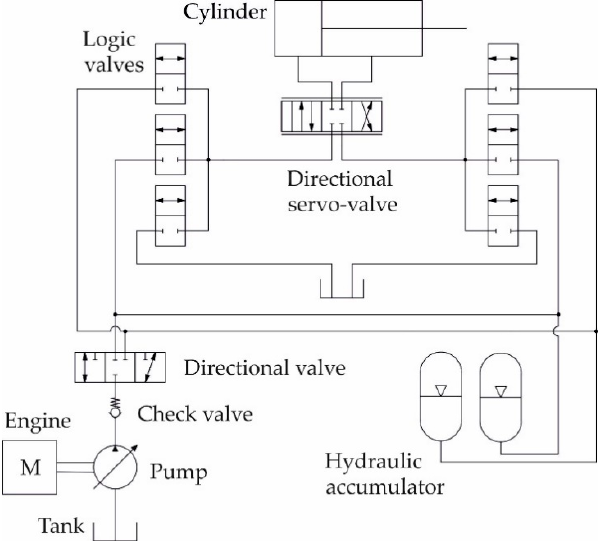
Figure 10. STEAM system with a servo-valve and logic valves.